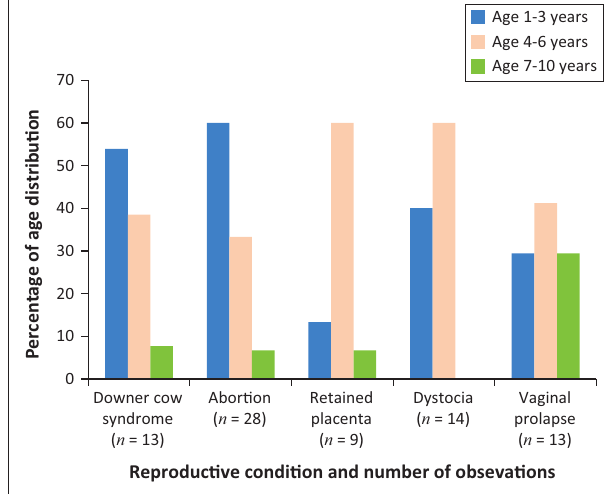
FIGURE 2: Age association with the occurrence of reproductive conditions in cows.